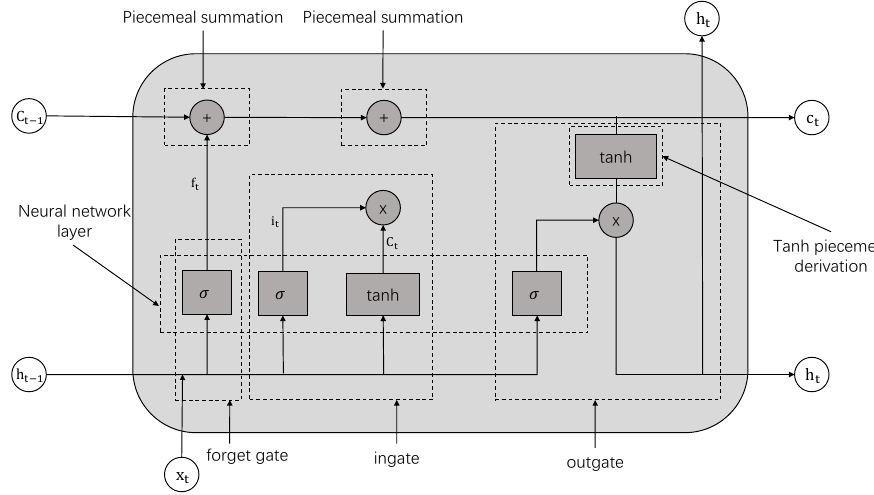
Figure 3. The diagram of the long short-term memory (LSTM)